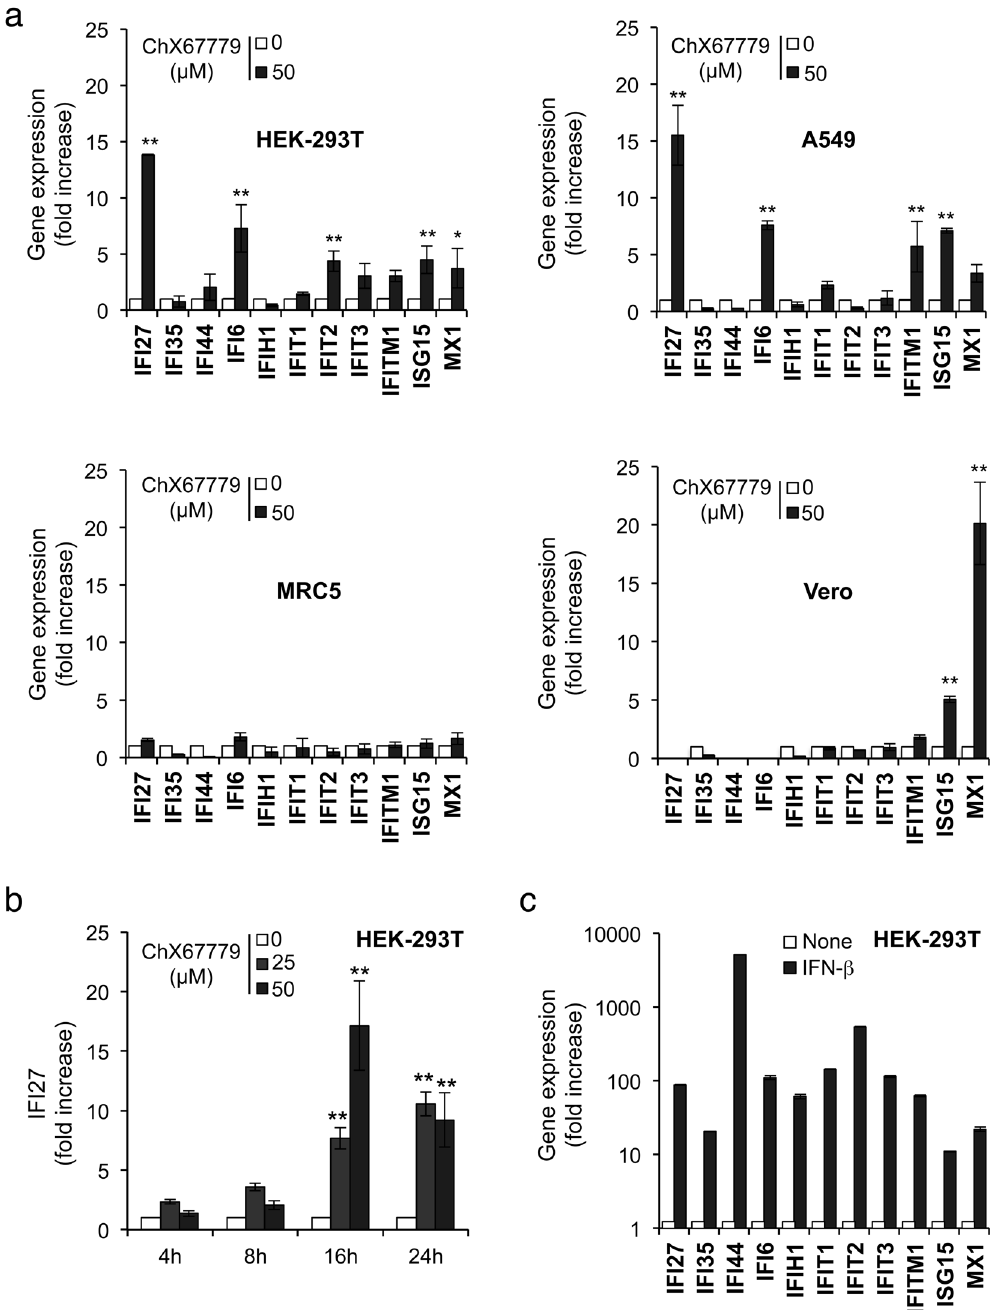
Figure 2. Induction of IFN-inducible genes (ISGs) by ChX67779. ( a ) HEK-293T, A549, MRC5 and Vero cells at 2 × 10 5 cells/well in 24-well plates were stimulated with DMSO alone or ChX67779 at 50 μ M. After 24 hours of culture, total RNAs were extracted, and expression levels of indicated genes were quantified by qRT-PCR. Data were normalized to the average expression of four housekeeping genes (18 S, GUSB, GAPDH, and HPRT1), and expressed as induction folds relative to DMSO-treated cells using the 2 −ΔΔ Ct method. ( b ) HEK-293T cells were left untreated (DMSO alone) or incubated with ChX67779 for 0, 4, 16 or 24 hours. IFI27 induction was determined by RT-qPCR as described above. ( c ) HEK-293T cells were left untreated or stimulated with recombinant IFN- β (500 IU/ml) for 24 hours. ISG expression levels were determined by RT-qPCR as described above. Experiments were performed in duplicate, and data represent means ± SD. * P < 0.05 and ** P < 0.01 as calculated by two-way ANOVA with Bonferroni’s post hoc